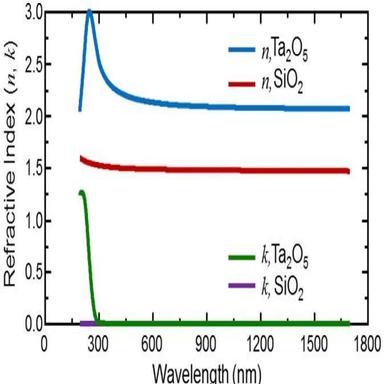
Optical functions for both low-index SiO2 and a TFs. (For interpretation of the references to color in this figure legend, the reader is referred to the web version of this article.) Fig. 9. Systematic testing of each individual layer provides (A) variation in